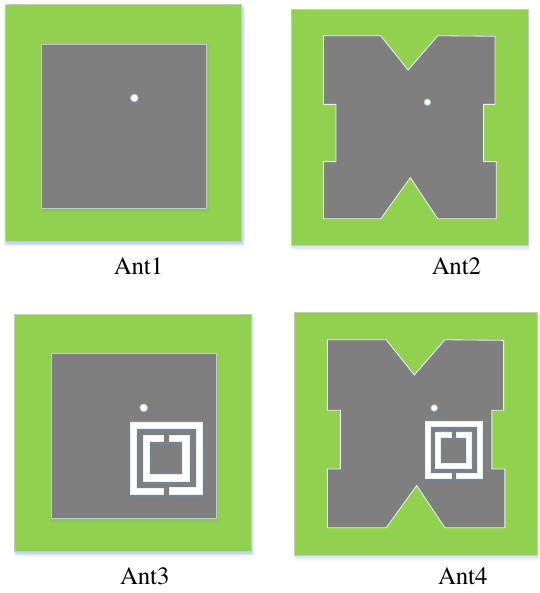
Figure 5: Evolution of the proposed antenna Initially, the square patch Ant1 is chosen as a reference which is resonating at 3.4 GHz with linear polarization. Poly fractal curves are introduced along edges of the square patch Ant1 to get Ant2 which results in CP. Ant3 can be obtained by introducing CSRR in the patch which results in double band operation with Linear Polarization. Ant4 represents the dual band dual polarization version achieved by introducing poly fractal curves to the edges of Ant3. Finally, Ant4 is the proposed antenna with dual band dual polarization.